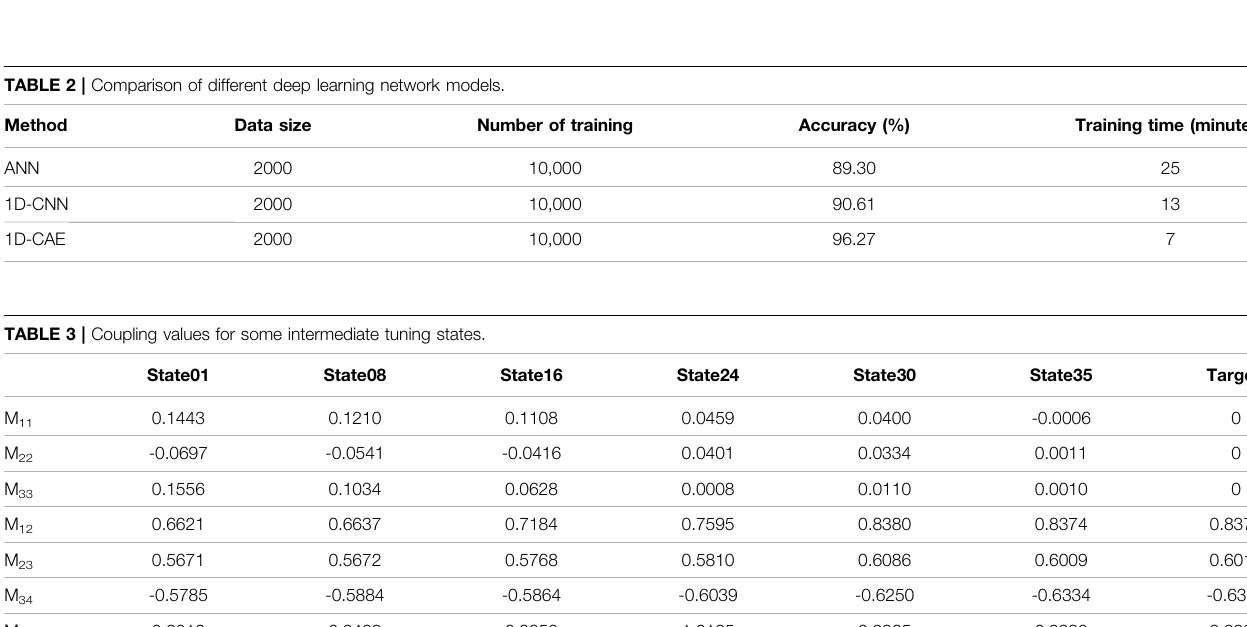
4A . The S- parameters obtained from the electromagnetic simulation software are removed from the phase shift and input into the 1D-CAE model. The corresponding coupling matrix will be quickly extracted.